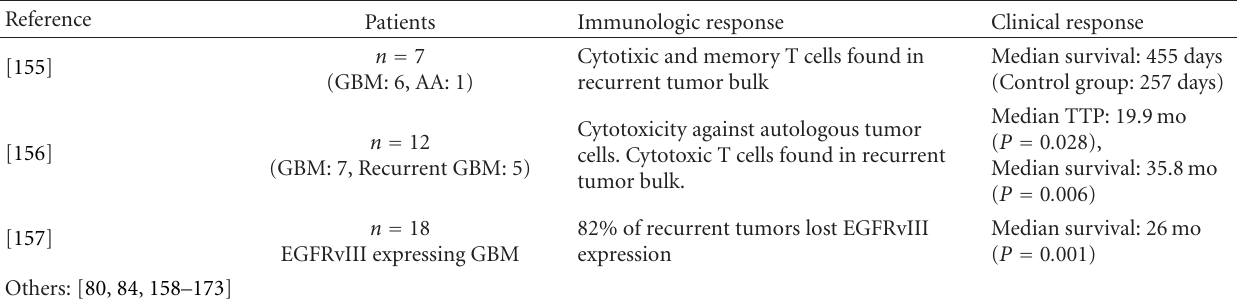
Table 4: Selected clinical trials using dendritic cells (DCs).